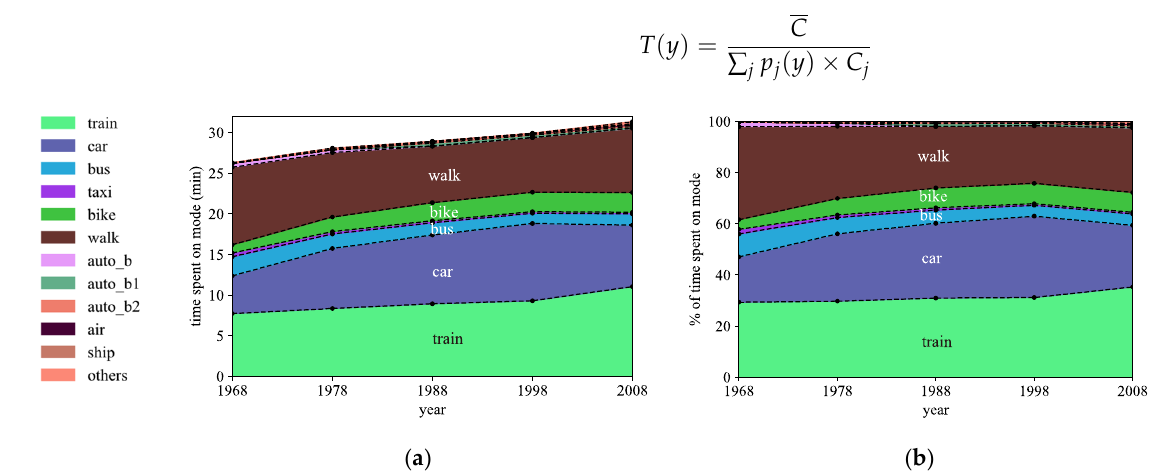
Figure 18. Travel modes for one trip. ( a ) Average time spent on travel modes for one trip; ( b ) Percentage of time spent on each travel mode for one trip.